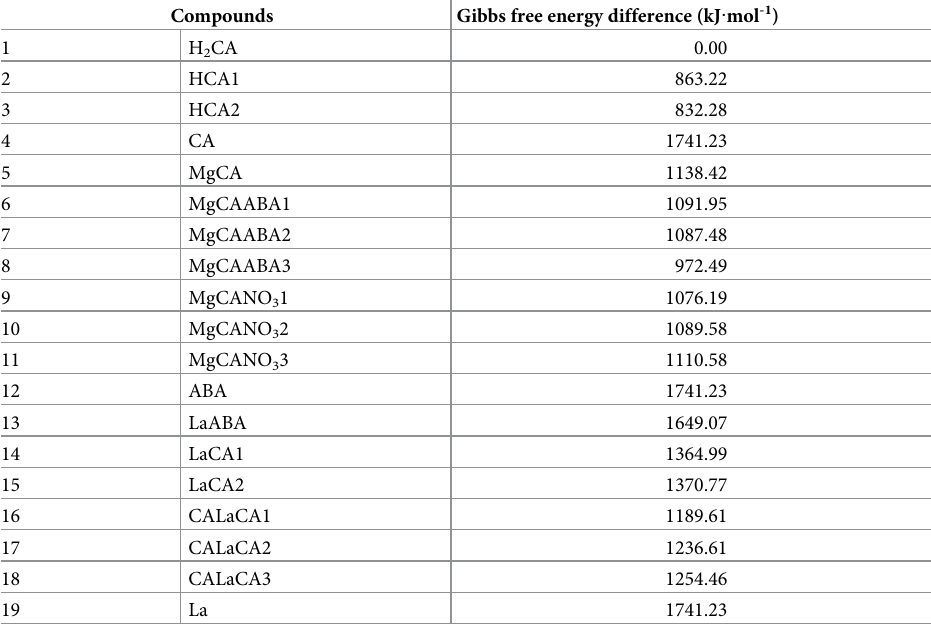
Table 1. Gibbs free energy